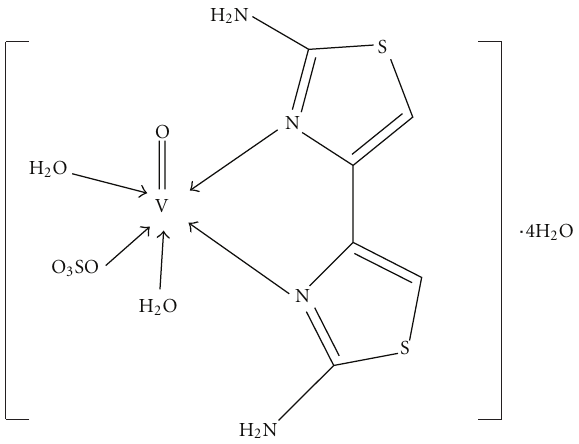
Figure 1: Van-7, [VO(SO 4 )(C 6 H 6 N 4 S 2 )(H 2 O) 2 ]4H 2